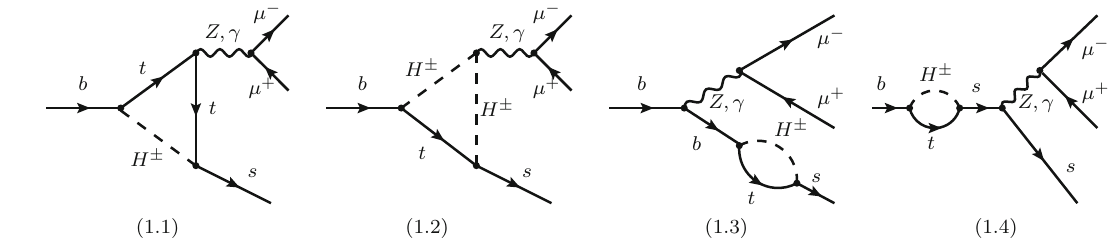
Fig. 1 Z - and photon-penguin diagrams involving the charged-scalar exchanges in the